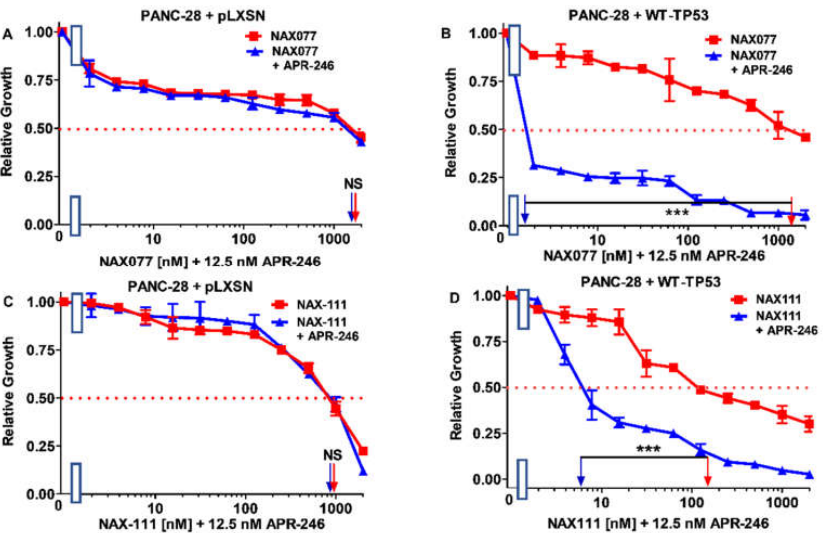
Figure 16. APR-246 enhances the effects of NAX077 and NAX11 on PANC-28 cells in the presence of WT-TP53 but not in the absence of WT-TP53. Panel ( A ) PANC-28 + pLXSN cells treated with different concentrations of NAX075 (red squares) or with different concentrations of NAX075 and a low dose of APR-246 (blue triangles). Panel ( B ) PANC-28 + WT-TP53 cells treated with different concentrations of NAX075 (red squares) or with different concentrations of NAX075 and a low dose of APR-246 (blue triangles). Panel ( C ) PANC-28 + pLXSN cells treated with different concentration of NAX111 (red squares) or with different concentrations of NAX111 and a low dose of APR-246 (blue triangles). Panel ( D ) PANC-28 + WT-TP53 cells treated with different concentrations of NAX111 (red squares) or with different concentrations of NAX111 and a low dose of APR-246 (blue triangles). The measurements were repeated 3 times, and similar results were observed. *** = p < 0.0001, and NS, not statistically significant.